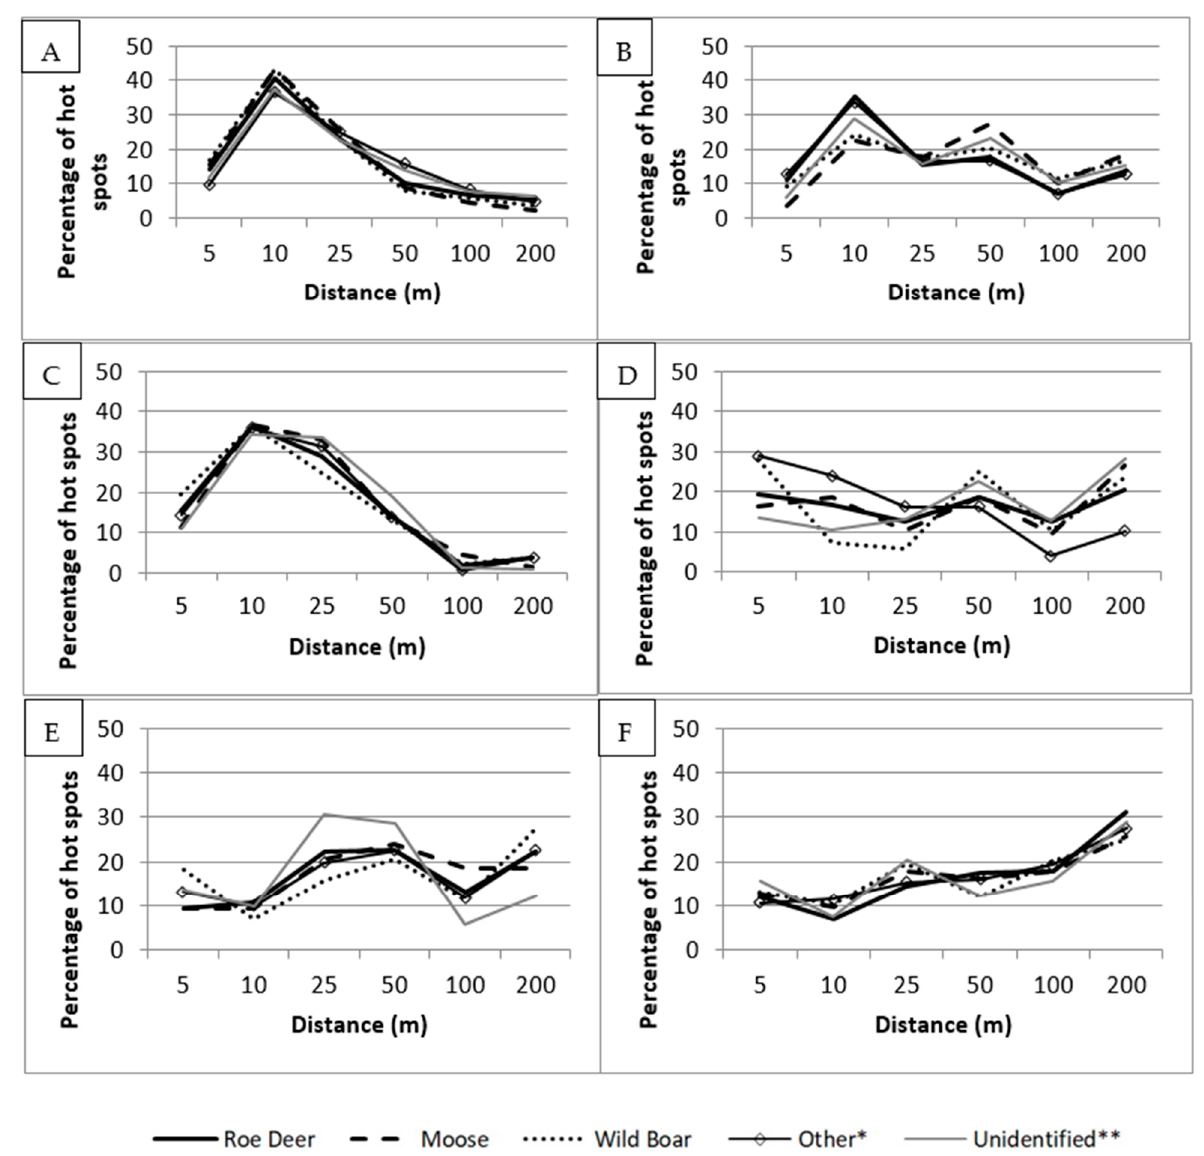
Figure 2. Distribution of species-specific WVC hot spots at different distances for each land-use type: ( A ) forests, ( B ) agricultural land, ( C ) meadows and pastures, ( D ) built-up areas, ( E ) rivers, ( F ) lakes and ponds. * Includes 23 species of wild and domestic animals that comprise less than five percent of total accidents in any separate year. ** Includes cases in database with record ‘animal’.